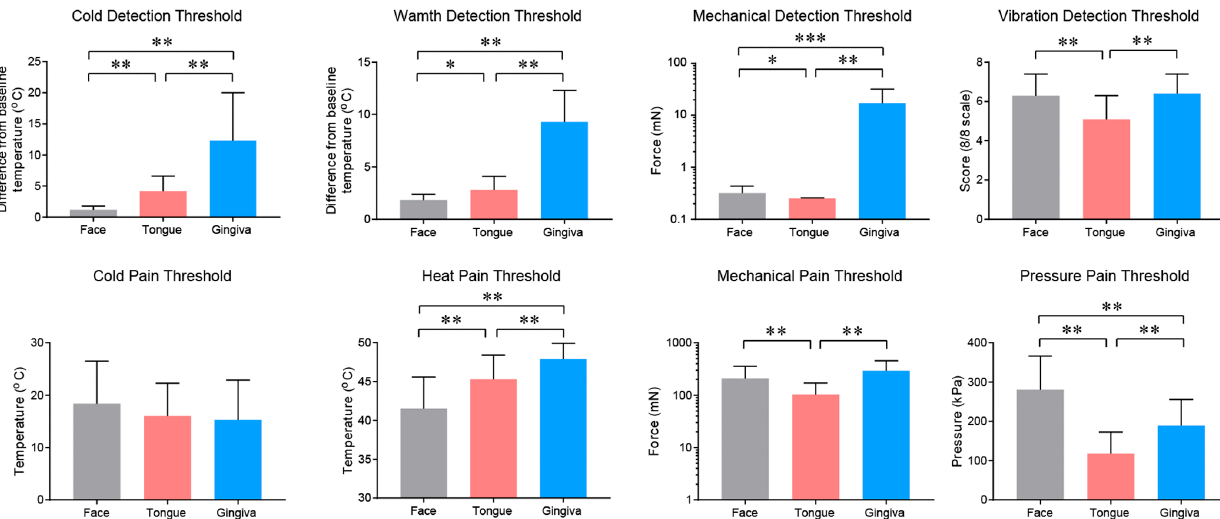
Figure 2. Different sensations of intraoral mucosa and extraoral skin. Results of quantitative sensory testing (QST) in 21 healthy subjects (13 women and 8 men; mean 40.4 years) on the cheek, tip of the tongue, and gingival mucosa of the upper premolar region. Mean ± SD; * p < 0.05, ** p < 0.01, and *** p < 0.001; paired t -test following Bonferroni correction for multiple comparisons. Plots were redrawn using previously published data from Pigg et al. [9], with kind permission.